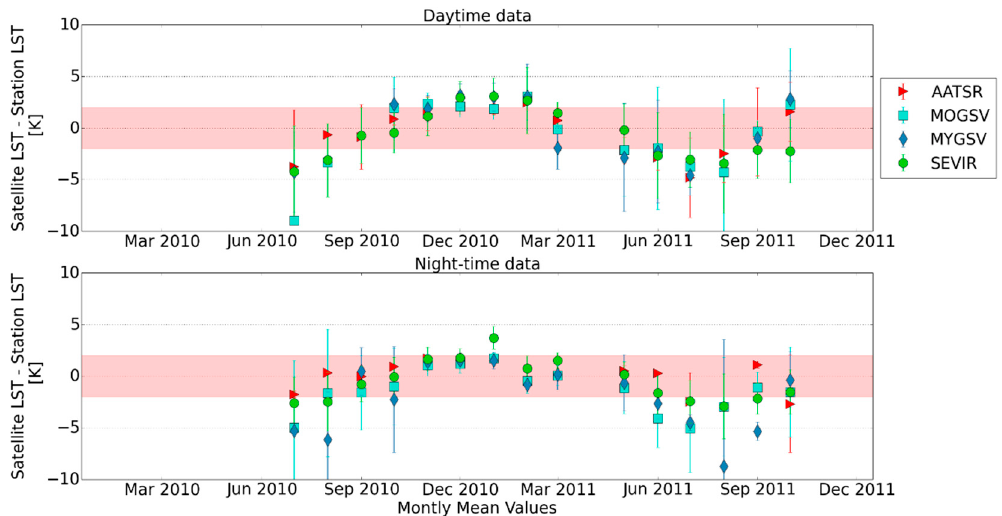
Figure 12. Monthly median accuracies (satellite LST–station LST) over DAH_T station for the years 2010–2011. The upper plot shows daytime and the lower night-time data. The ranges shaded in red indicate the ± 2.0 K accuracy range.